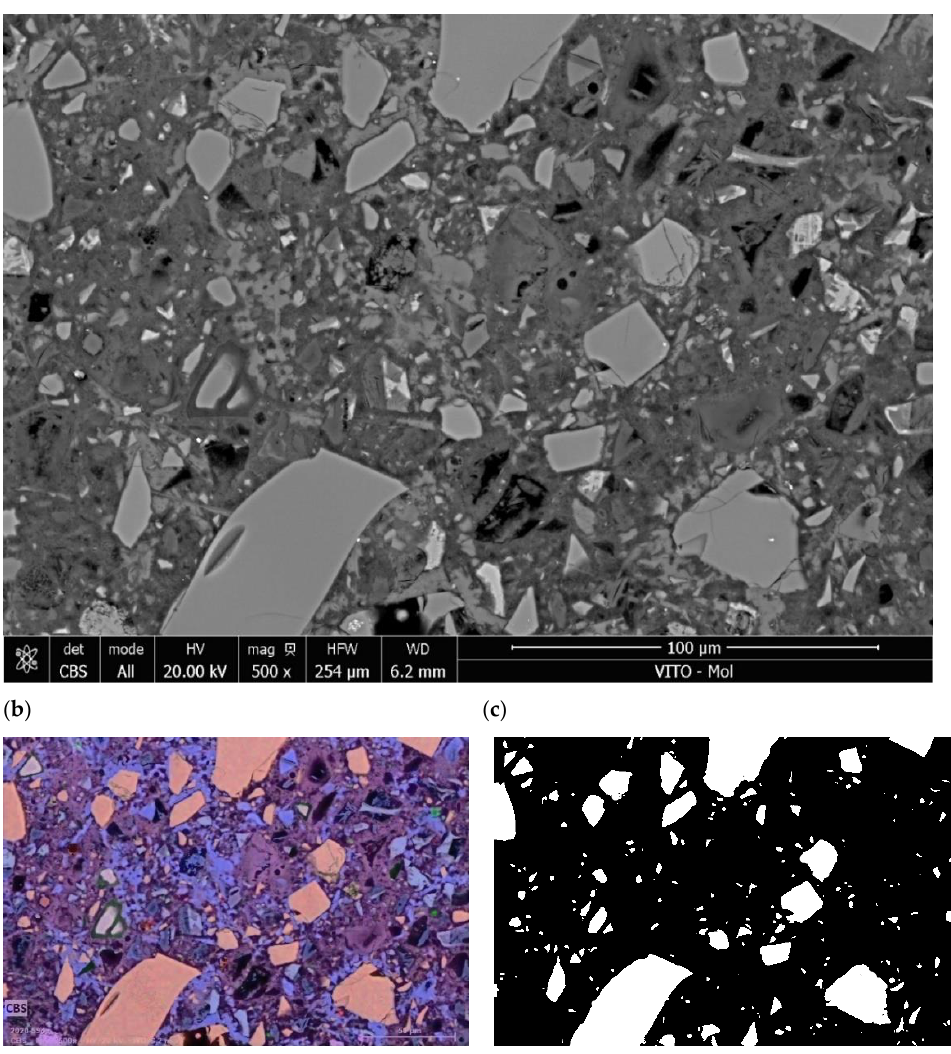
Figure 2. Sample raw and processed images. ( a ) BSE image, ( b ) combined BSE+EDS image and ( c ) segmented image.